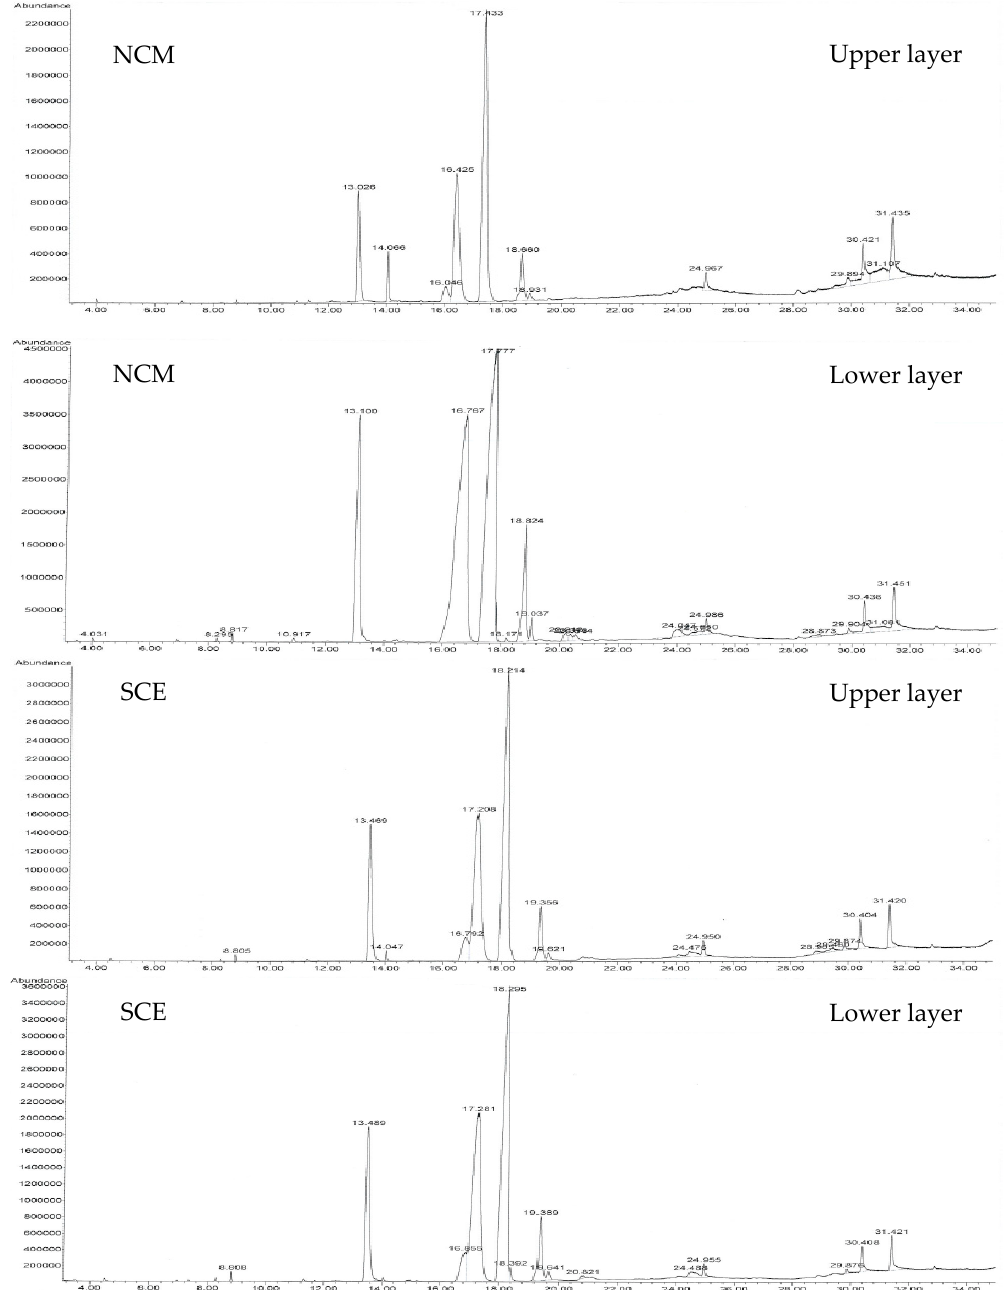
Figure 7. GC chromatogram of products from WCO by the supercritical method.